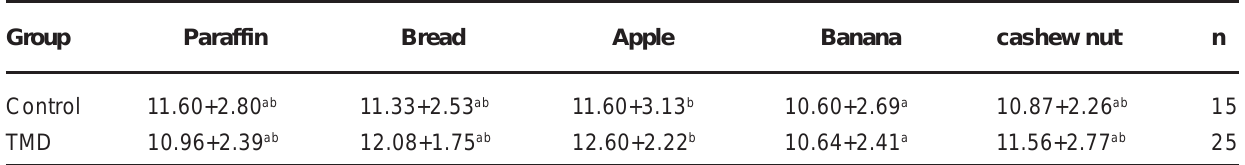
Groups with the same letters are not statistically different.